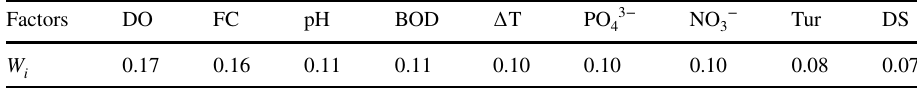
Table 2 NSF-WQI (weight of the parameters)